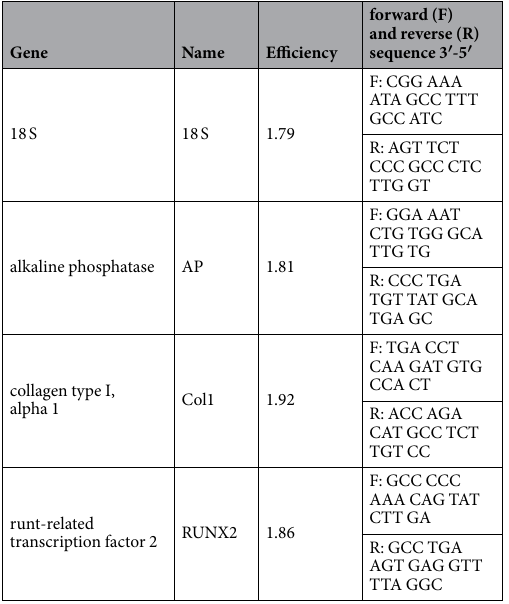
Table 3. All primer pairs were designed with the Primer3web web page and intron spanning. Using the OligoAnalyzer 3.1 software all primer pairs were tested for self-dimers, hetero-dimers or hairpin production. The amplicon size was chosen between 150–250 base